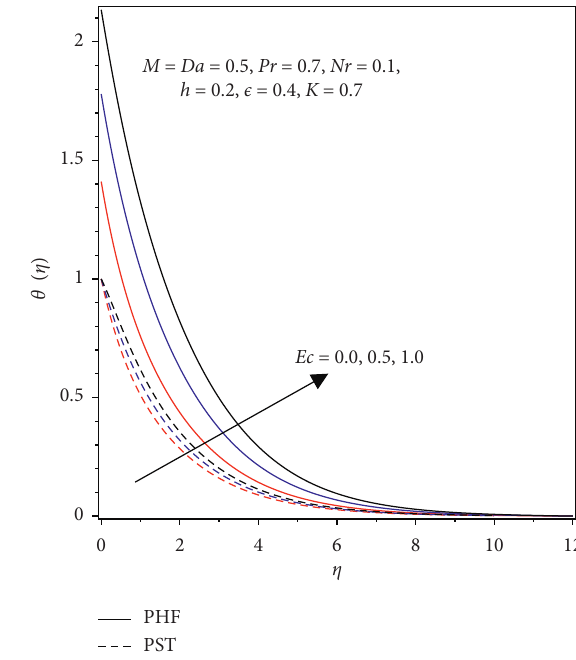
Figure 7: Impact of Prandtl number Pr on the field of temperature.